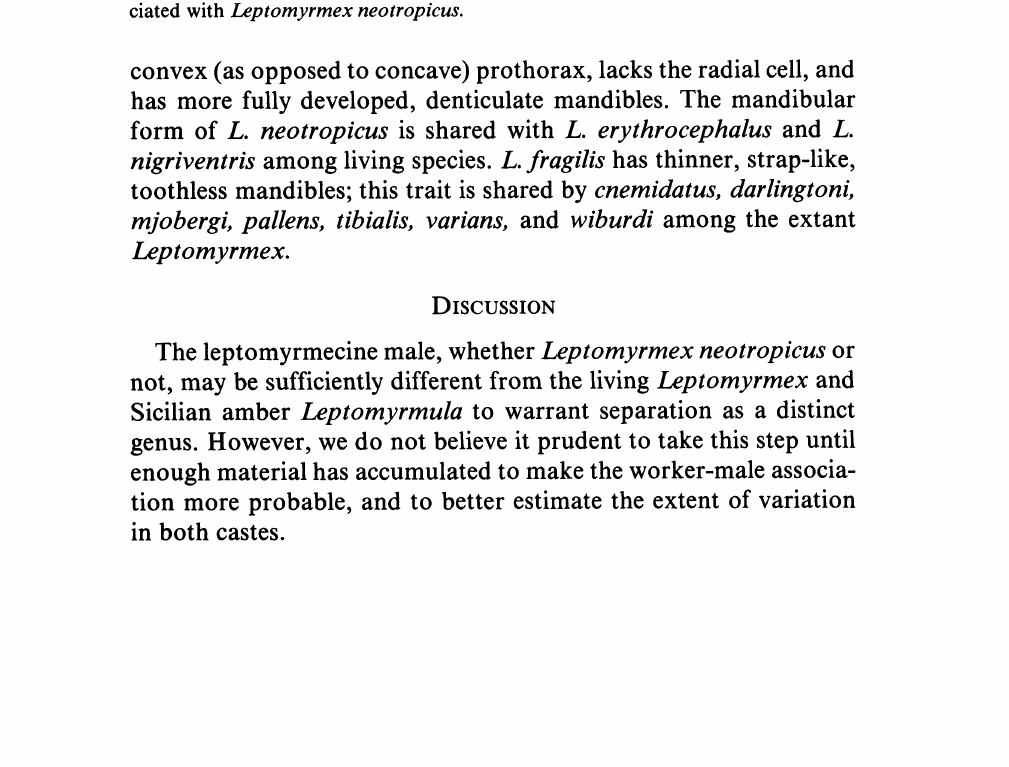
Figure 2. Leptomyrmecine male from the Dominican amber tentatively asso- ciated with Leptomyrrnex